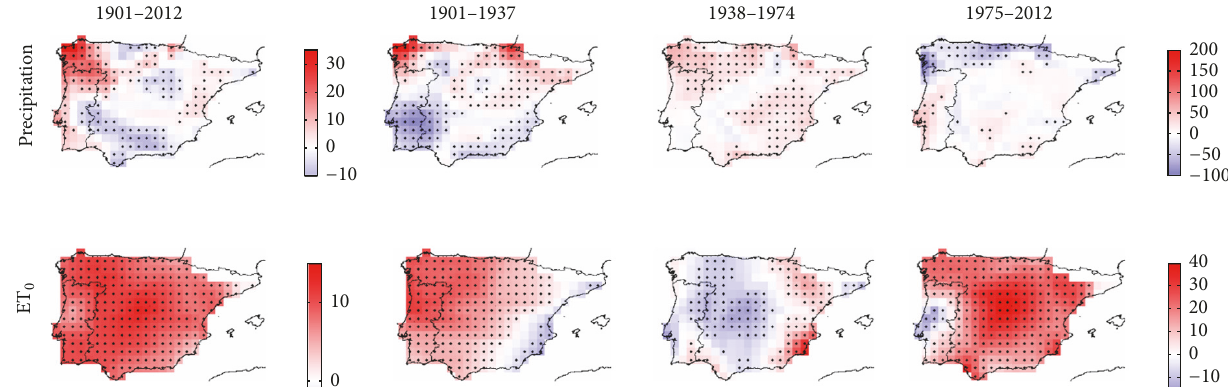
Figure 3: Spatial patterns of moving sums of precipitation and ET 0 trends for the total period and the three subperiods considered. ET 0 was estimated with the Hargreaves method. Statistically significant trends (at the 5% level) are indicated with a dot (scale is mm/decade).